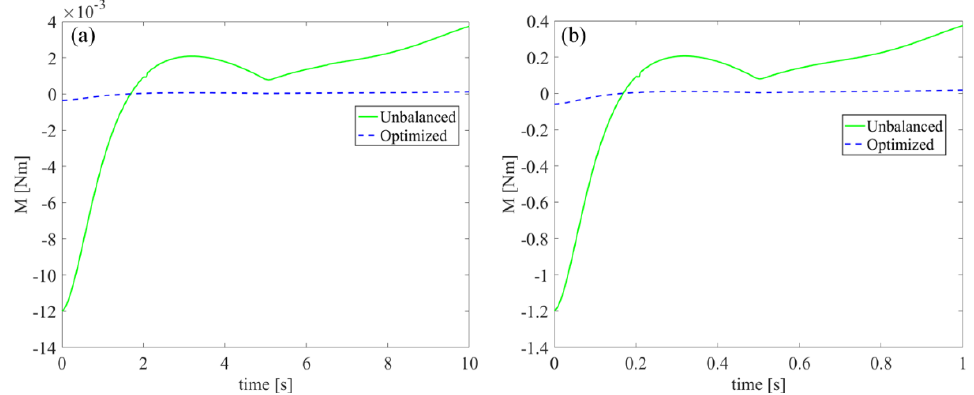
Figure 13. The shaking moment of the unbalanced and optimized SPR at ( a ) “low” and ( b ) “high” for trajectory 2.